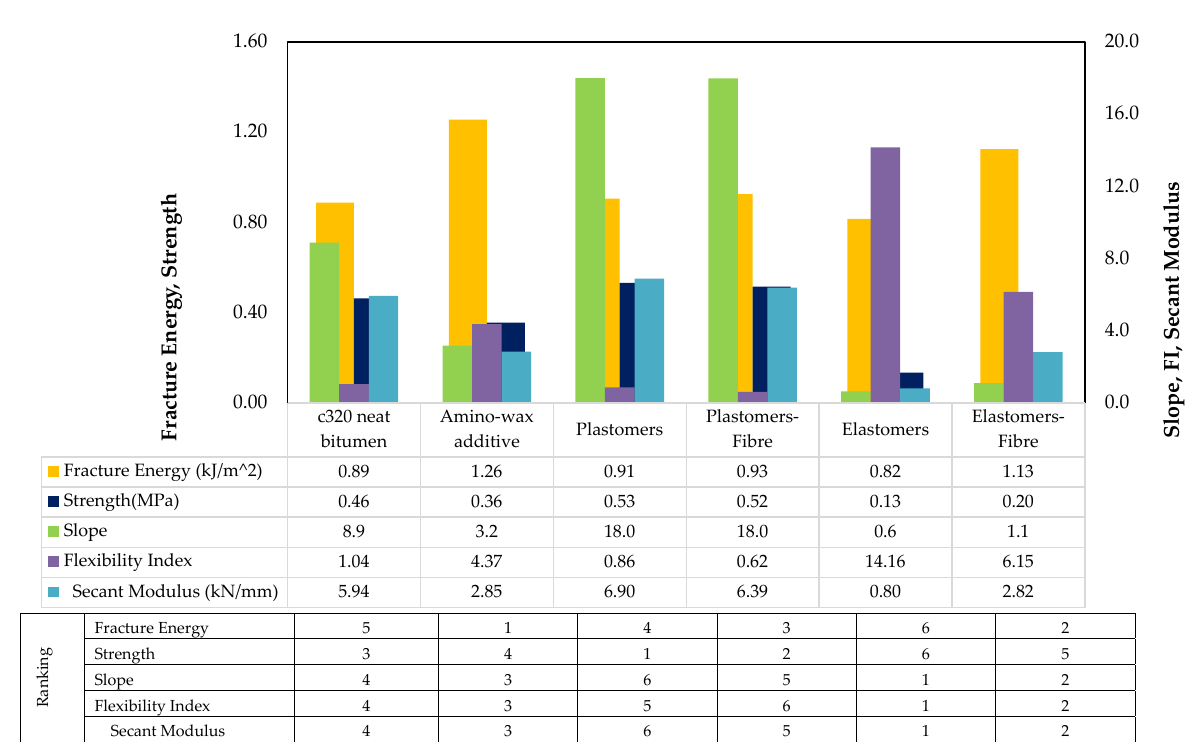
Figure 9. Ranking and properties of HMA mixes@25 °C for the SCB test.